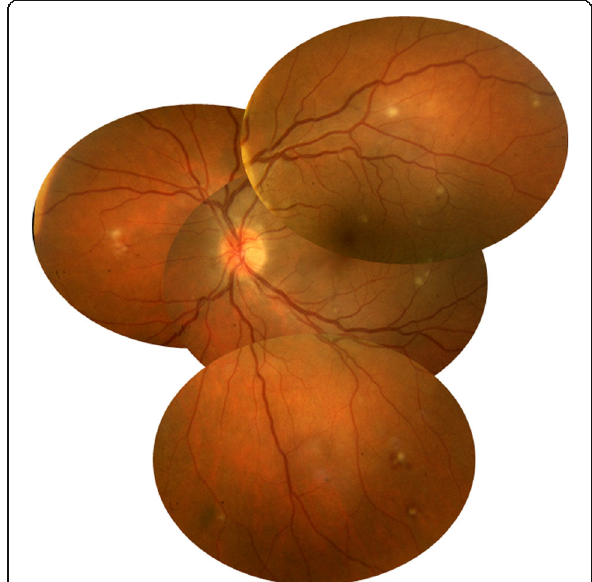
Fig. 1 A 42-year-old patient complained of floaters. He reported a 2- week history of fever and malaise. Composite fundus photograph of